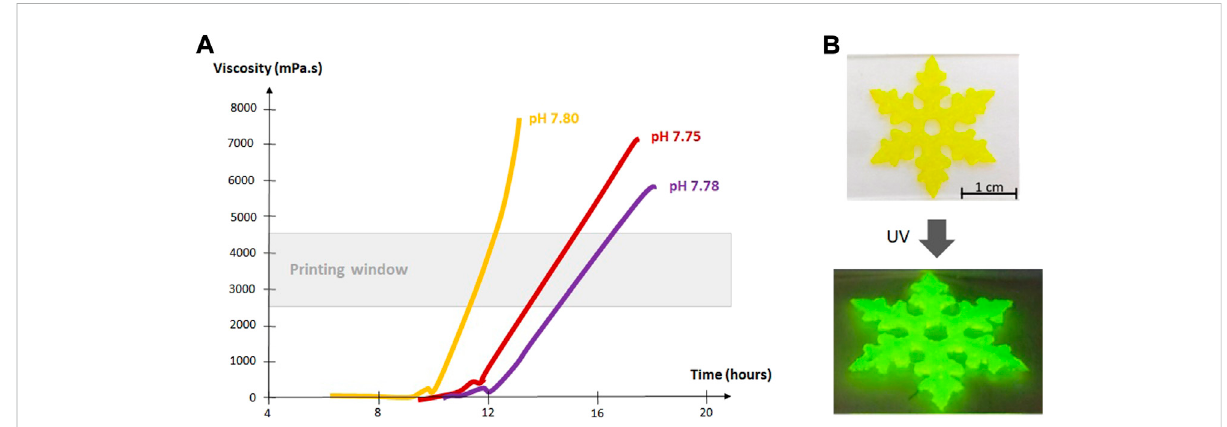
FIGURE 3 (A) Viscosity of hybrid PEG hydrogels in chondrogenic medium (yellow curve), proliferative medium (red curve) and DPBS (purple curve) (37 ° C, 0.1 mg/ml NaF, 143 mM glycine). (Valot et al., 2019b).The printability window was determined by extrusion tests run in parallel with viscosity